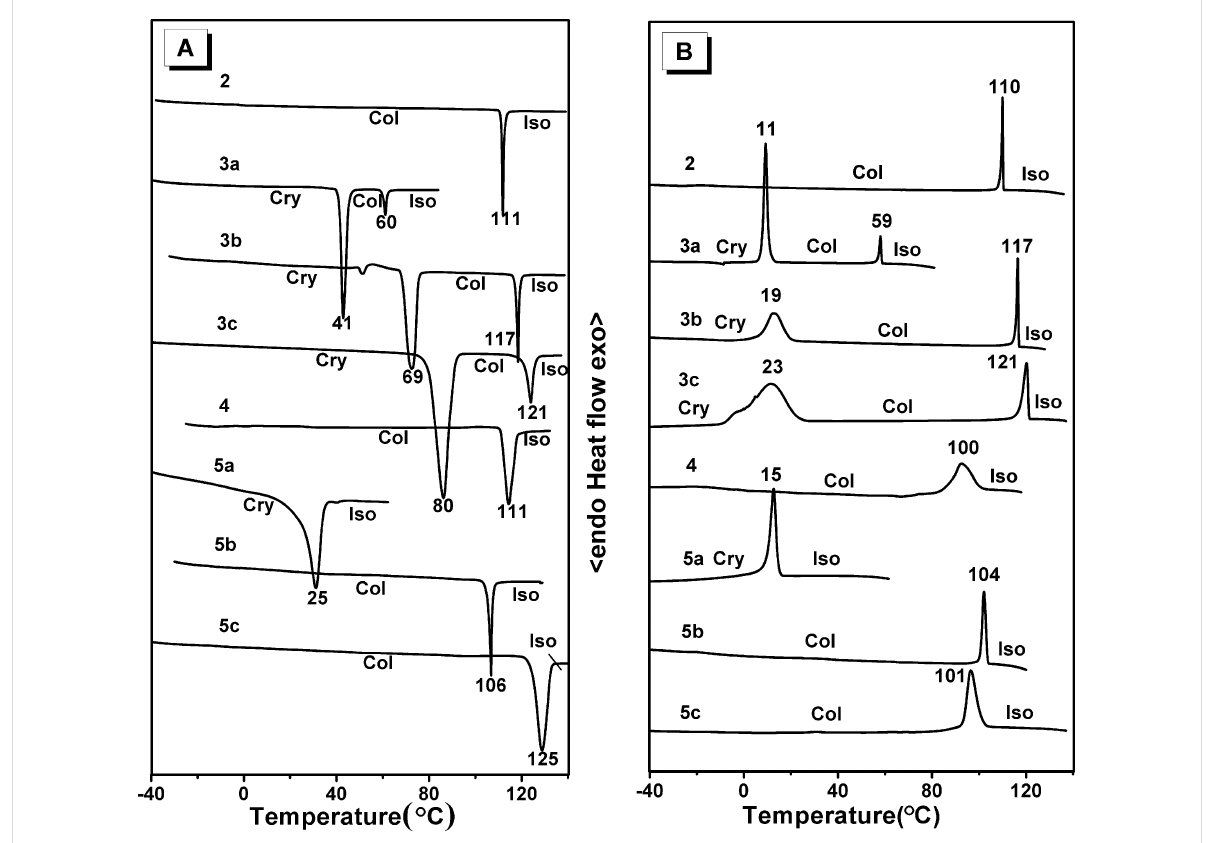
For the mesomorphism of the functionalized triphenylene monomers, compound 2 [52] and 3b [57] have been reported,